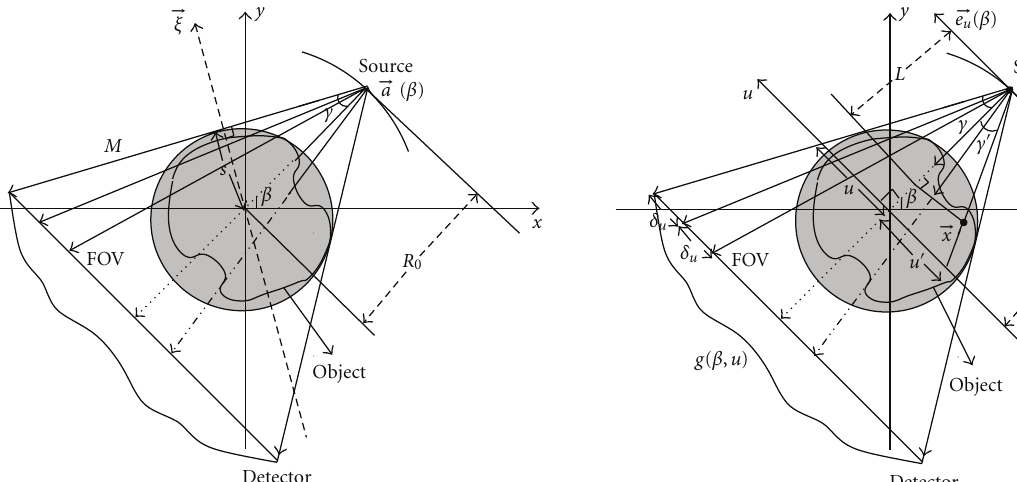
Figure 3: Fan-beam equispaced linear array detector scanning